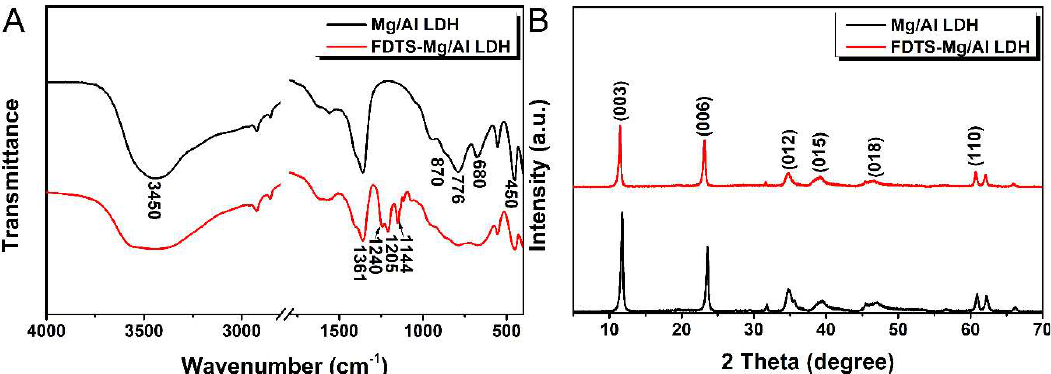
Figure 3. FTIR spectra ( A ) and X-ray diffraction patterns ( B ) of Mg-Al LDH and FDTS-modified Mg/Al LDH.